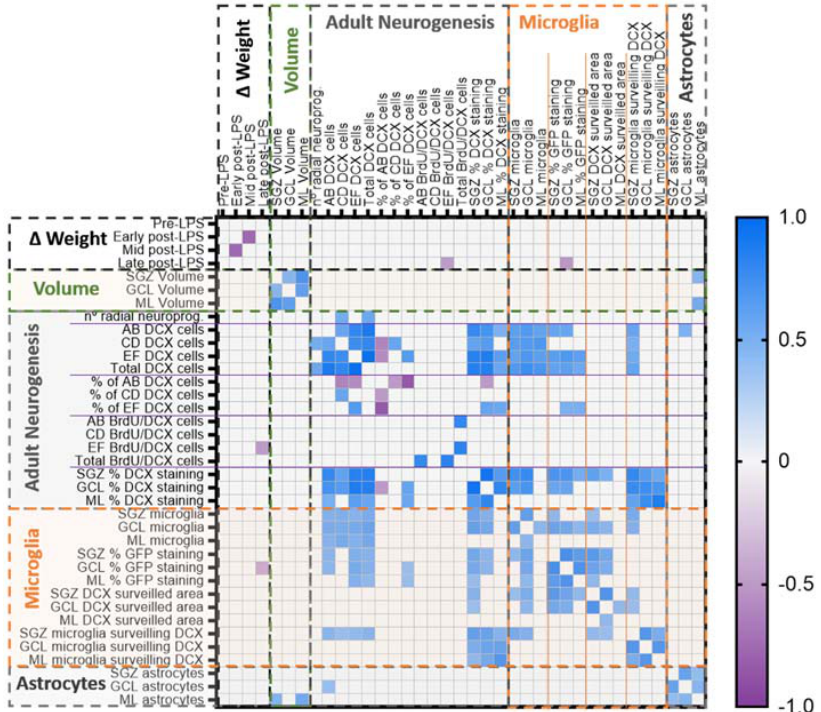
Figure 9. Correlation matrix analysis revealed multiple correlations between adult neurogenesis and microglia parameters. Dotted lines divide the different groups of parameters analyzed, and straight lines denote the subgroups of features related to adult neurogenesis. Only significant correlations ( p < 0.01) are depicted as colored squares in which the color tone represents the Spearman’s r value (check scale bar in the right, single values detailed in Supplementary Data).